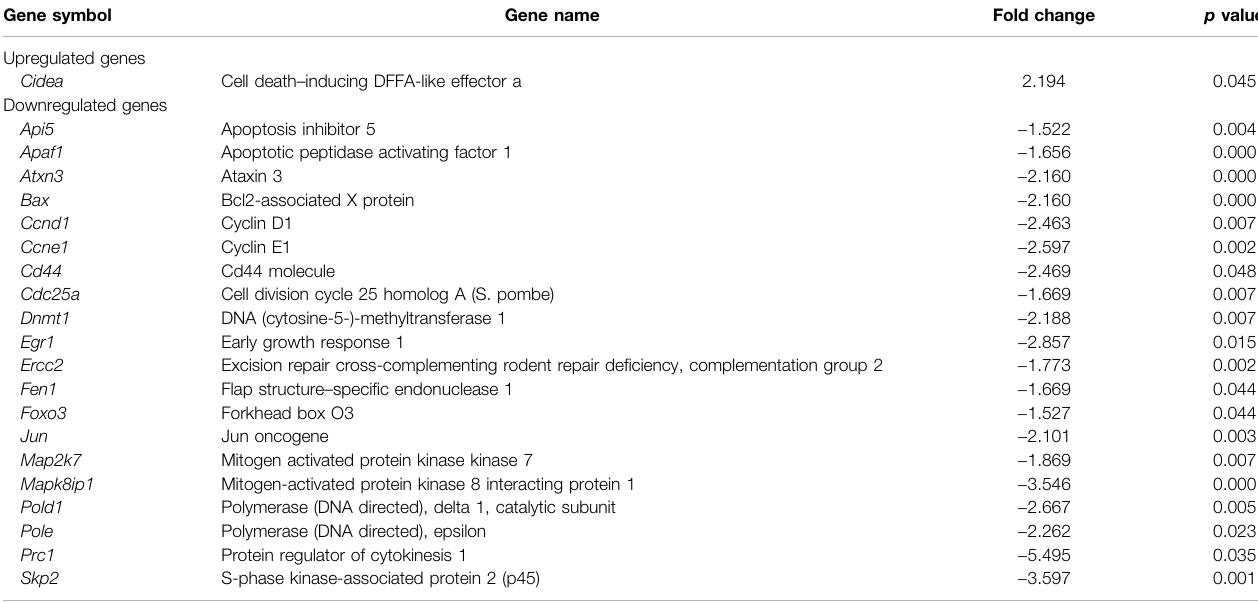
TABLE 4 | Effects of gestational and lactational low-protein diet on gene expression in female offspring mammary gland after acute MNU administration at PND 35 a .